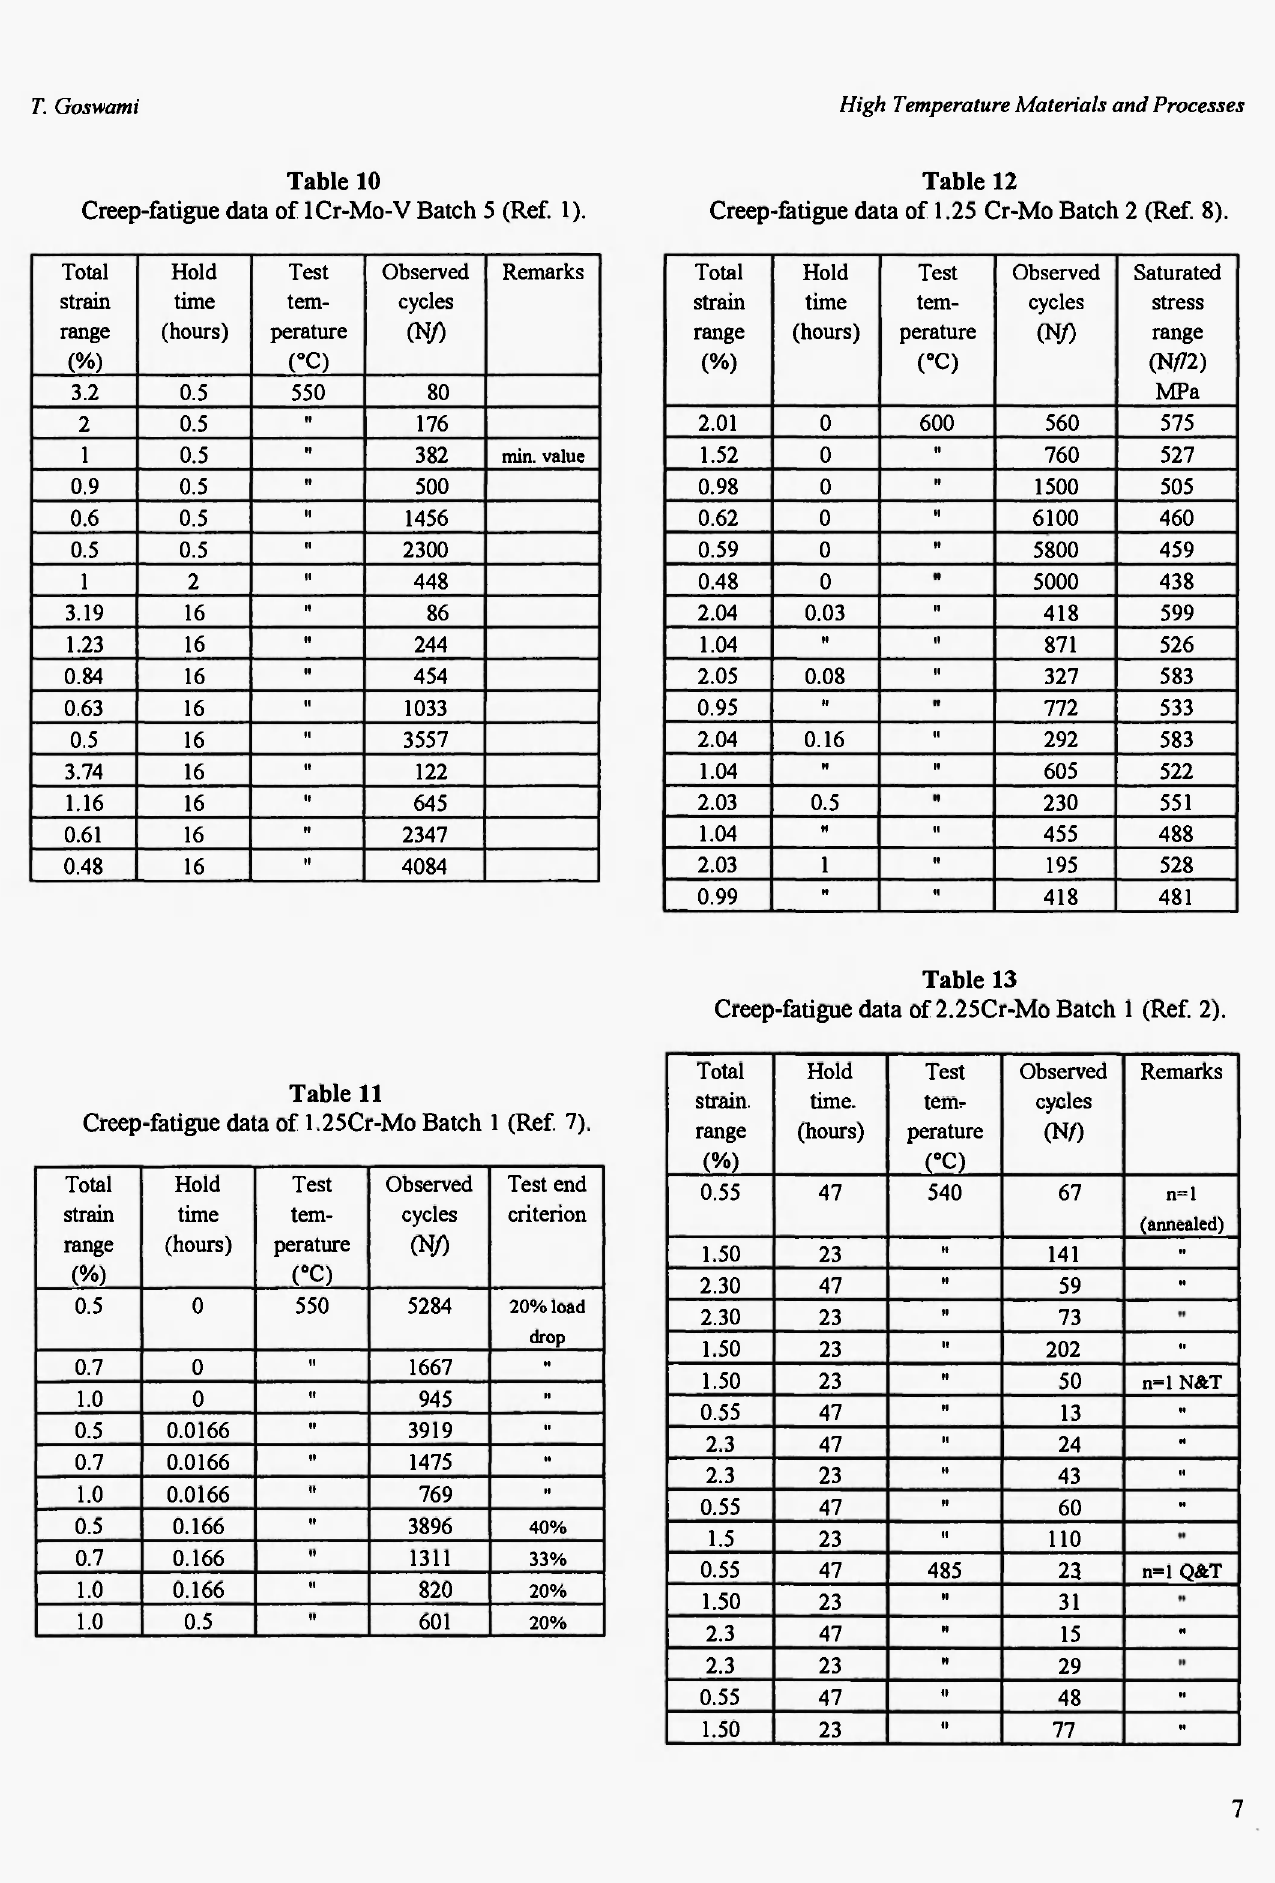
Creep-fatigue data of 1.25 Cr-Mo Batch 2 (Ref. 8).